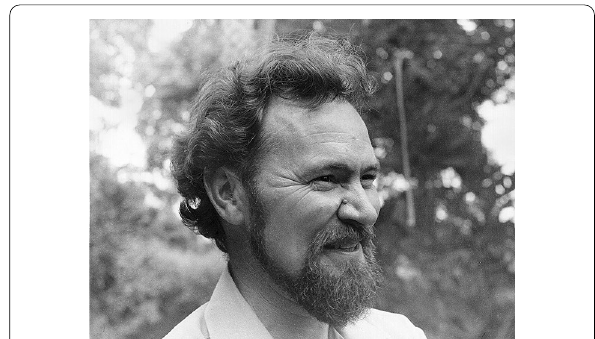
Fig. 1 John Ramsay during his time at ETH Zurich, 1980 (Image: ETH Library). Copyright Notice: ETH-Bibliothek Zürich, Bildarchiv / Fotograf: Unbekannt